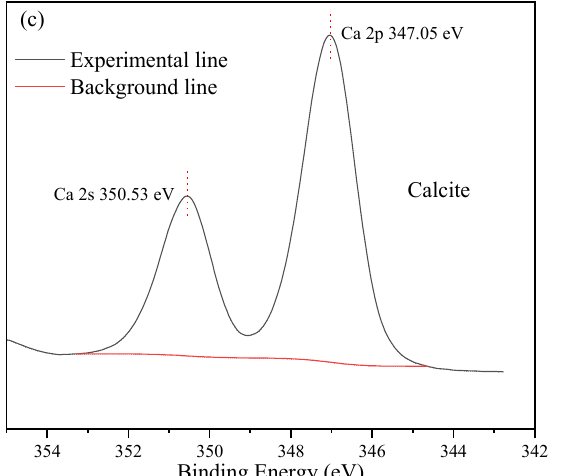
Figure 15. Schematic illustration of the selective flotation process.